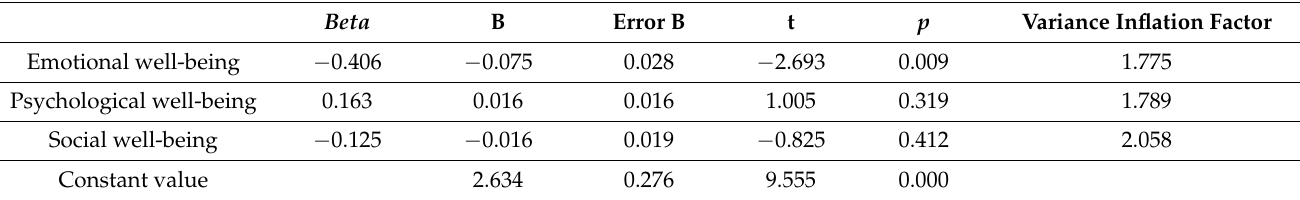
Table 12. PTSD predictors (individuals with anxiety) ( n = 70 in each